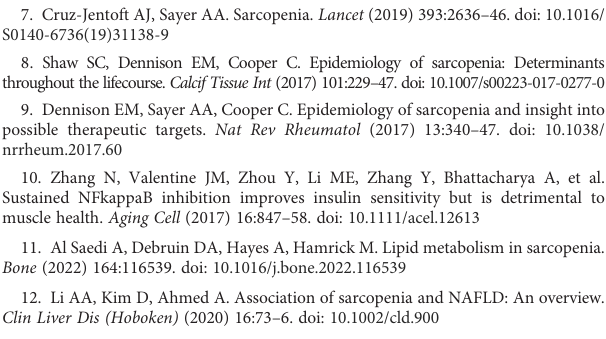
SUPPLEMENTARY FIGURE 1 Differential gene expression in NAFLD and Sarcopenia. (A) The PCA gene expression pro fi le in NAFLD and Sarcopenia patients; (B) The KEGG enrichment of the up-regulated pathway in sarcopenia; (C) The KEGG enrichment of the up-regulated pathway in NAFLD. SUPPLEMENTARY FIGURE 2 Determination of soft-threshold power in the WGCNA. (A) Analysis of the scale-free index for various soft-threshold powers ( b ). (B) Analysis of the mean connectivity for various soft-threshold